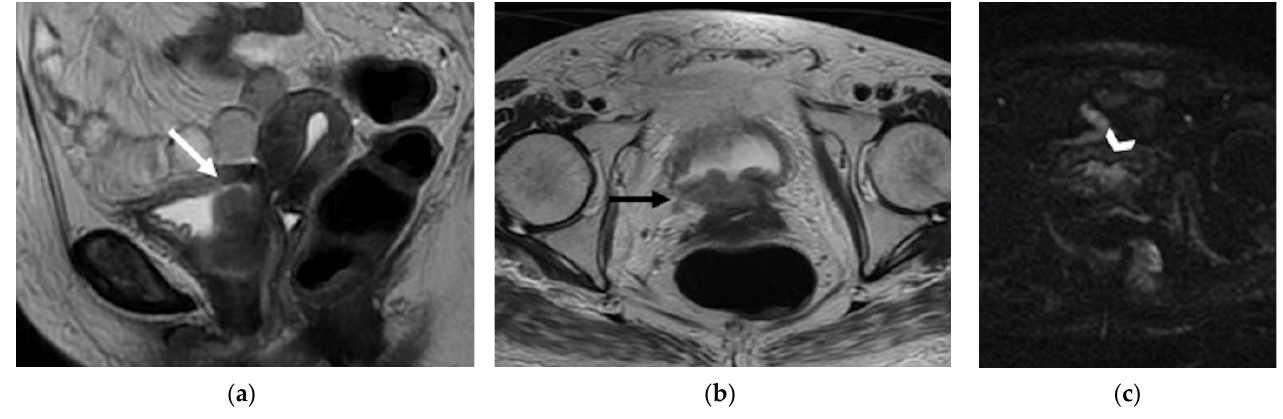
Figure 5. A 65-year-old woman who underwent chemoradiation therapy for cervical cancer. ( a ) Sag- ittal and axial ( b ) FSE T2-weighted image show an anterior pelvic recurrence, characterized by a soft-tissue mass infiltrating the posterior bladder wall extending into the bladder lumen (white and black arrow). ( c ) The lesion appears hyperintense on diffusion-weighted images (arrowhead).